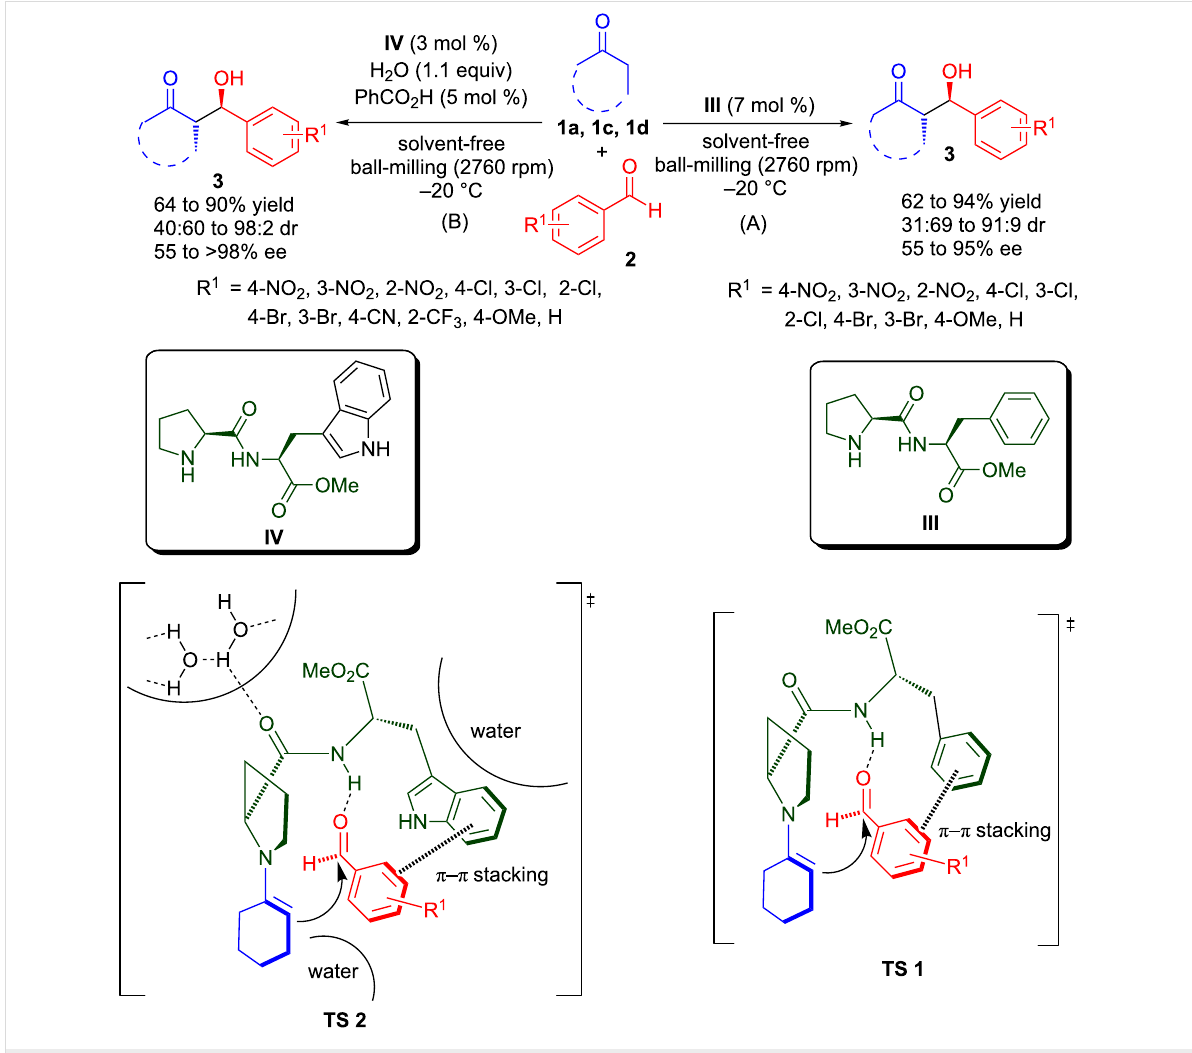
Scheme 4: Asymmetric aldol reaction assisted by ball-milling catalysed by dipeptides (A) with III and (B) with IV .